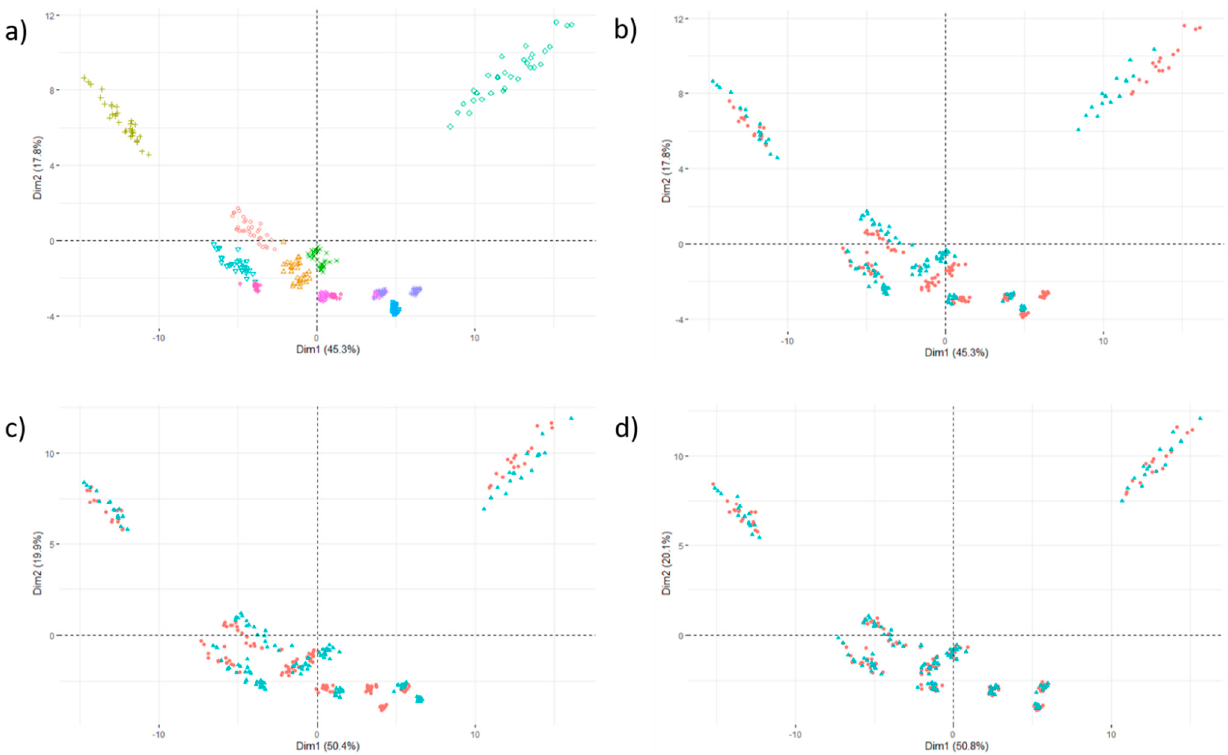
Figure 1. Principal component scores for 160 samples corresponding to 16 volumes of interest × 10 texture patterns represented by 10 different colors (see ( a )); ( b ) before ComBat (in red: CCR-2-001 scan; in blue: CCR-2-007 scan); ( c ) after ComBat with the same transformation for all texture patterns; ( d ) after ComBat applied separately for each phantom layer. After applying ComBat correctly, the data of the two scans are correctly aligned for all texture patterns.